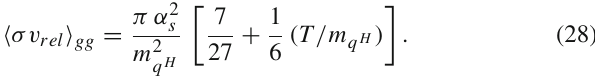
Fig. 6 The left panel is taken from [32] which omits heavy fermions. They are included in the figure on the right panel. The red solid curve, in both figures, is the XENON1T limit without ISV. The green solid line in the left (right) describes the XENON1T exclusion line with ISV value f n / f p = − 1 . 5 ( f n / f p = − 0 . 55). The small region of orange squares shows the fine-tuned region with f n / f p = − 1 . 86 for the left panel and f n / f p = − 2 . 00 for the right panel. These areas are allowed by RD and DD